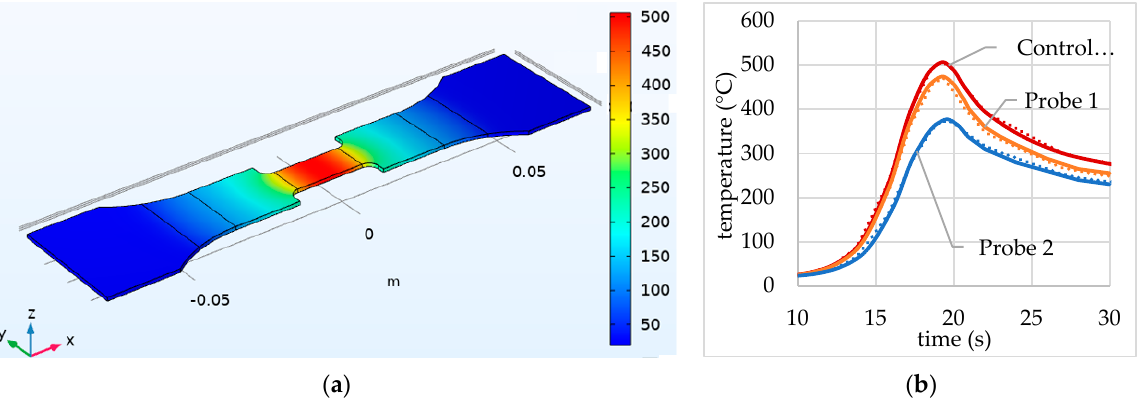
Figure 13. ( a ) Peak temperature distribution (T500V5). ( b ) Comparison between experimental (dotted line) and numerical (solid line) thermal cycles (T500V5).